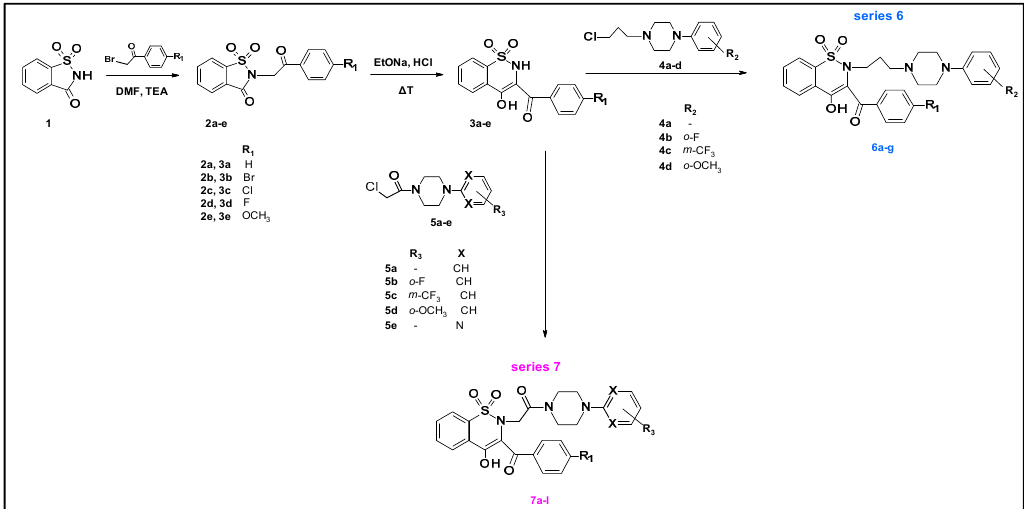
Scheme 2. Syntheticrouteofseries6and7compounds. TEA—triethylamine,